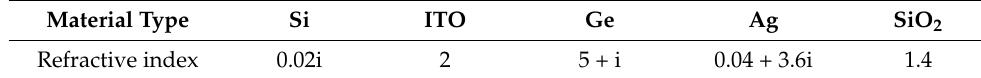
Figure 2. ( a ) SEM images and EDS element maps of SST film; ( b ) the measured complex refractive index of SST(n,k). Table 1. Optical material parameters for the